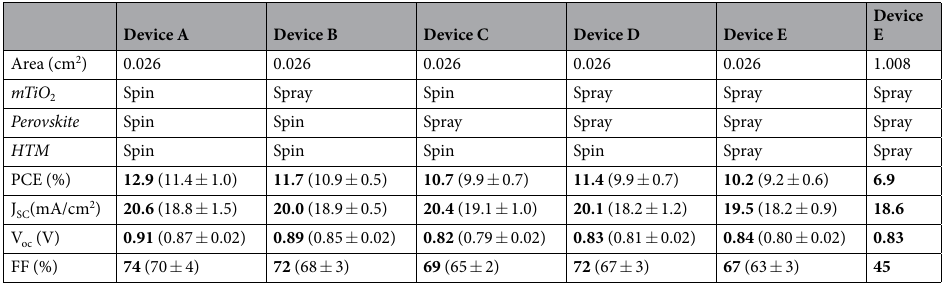
Table 2. A summary of PSC performance metrics and deposition technique used to fabricate each layer. Bold is the peak value with the average and standard deviation presented in